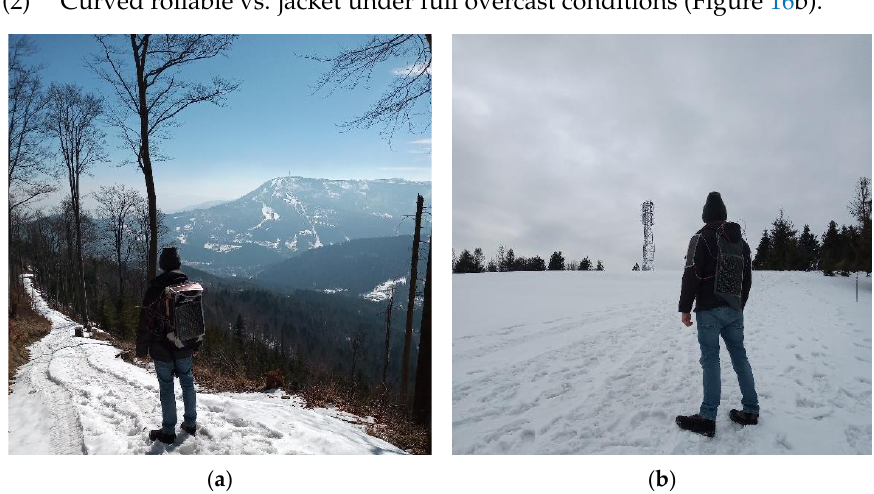
Figure 16. PV generator tests in real use conditions: ( a ) Backpack option 2 configuration tested under a lightly cloudy sky; ( b ) Jacket configuration tested under an overcast sky.